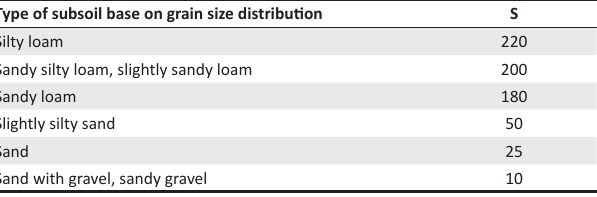
TABLE 4: Subsoil range in P-factor.